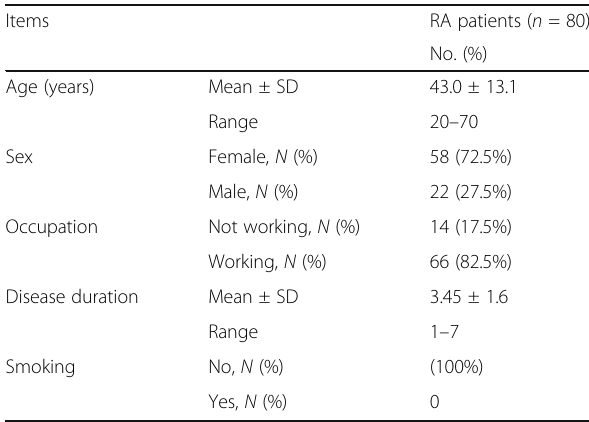
Table 1 Demographic data of RA patients Items